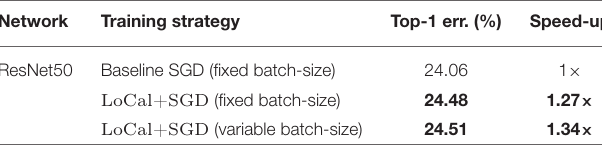
TABLE 4 | Analyzing impact of increasing batch-size on